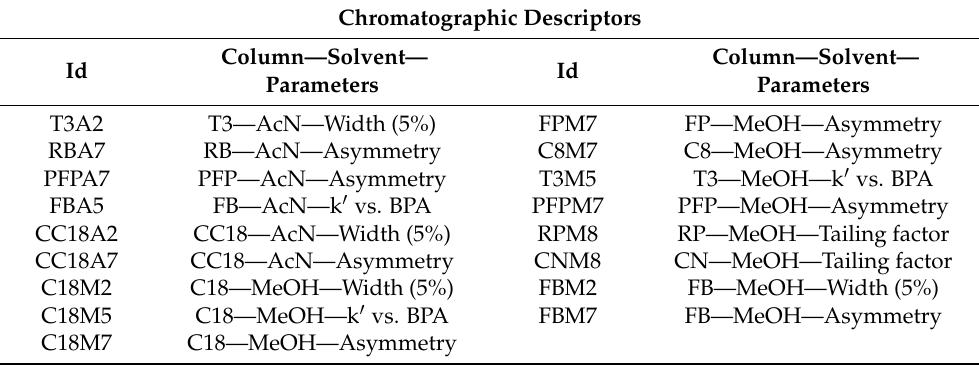
Table 4. Chromatographic descriptors with weight in the artificial neural networks higher than twice the median of all descriptors’ weight and selected to build the QSAR model for predicting placental